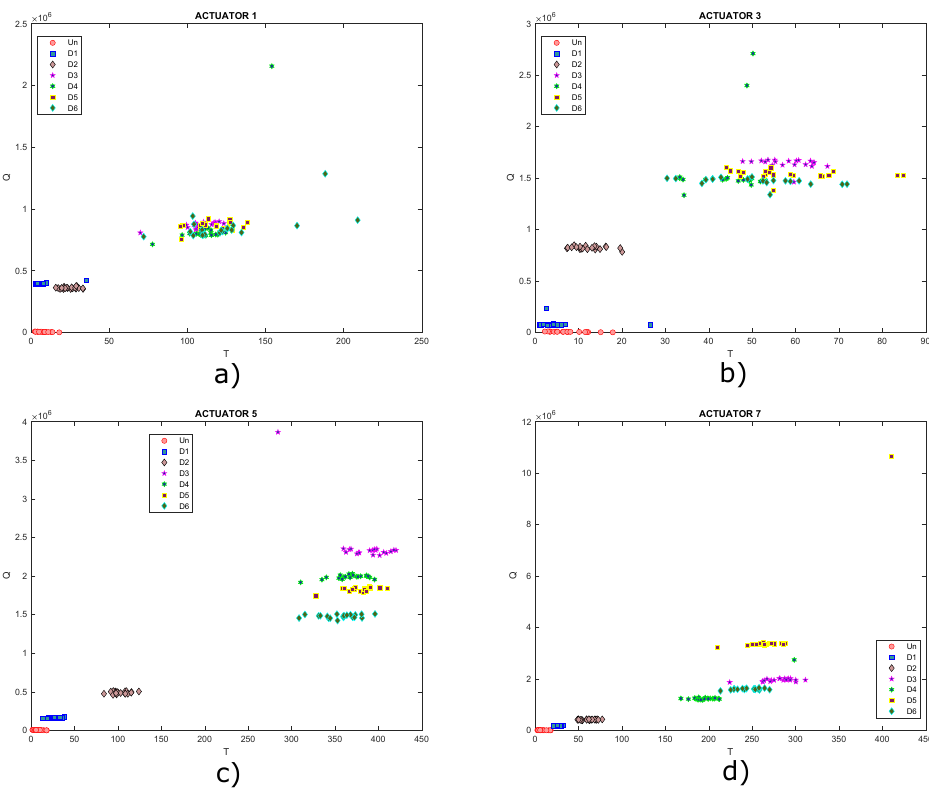
Figure 33. Graphs of T 2 vs. Q for actuation phases: ( a ) 1; ( b ) 3; ( c ) 5 and ( d ) 7. Next, Figure 34 presents the results obtained with the implementation of the CPANN, SKN, and XYF neural networks. In Figure 34, the structural states are represented by different colors: blue is for undamaged state, red is for damage 1, green is for damage 2, yellow is for damage 3, magenta is for damage 4, dark green is for damage 5 and gray is for damage 6. This results are obtained using features from all actuation phases.